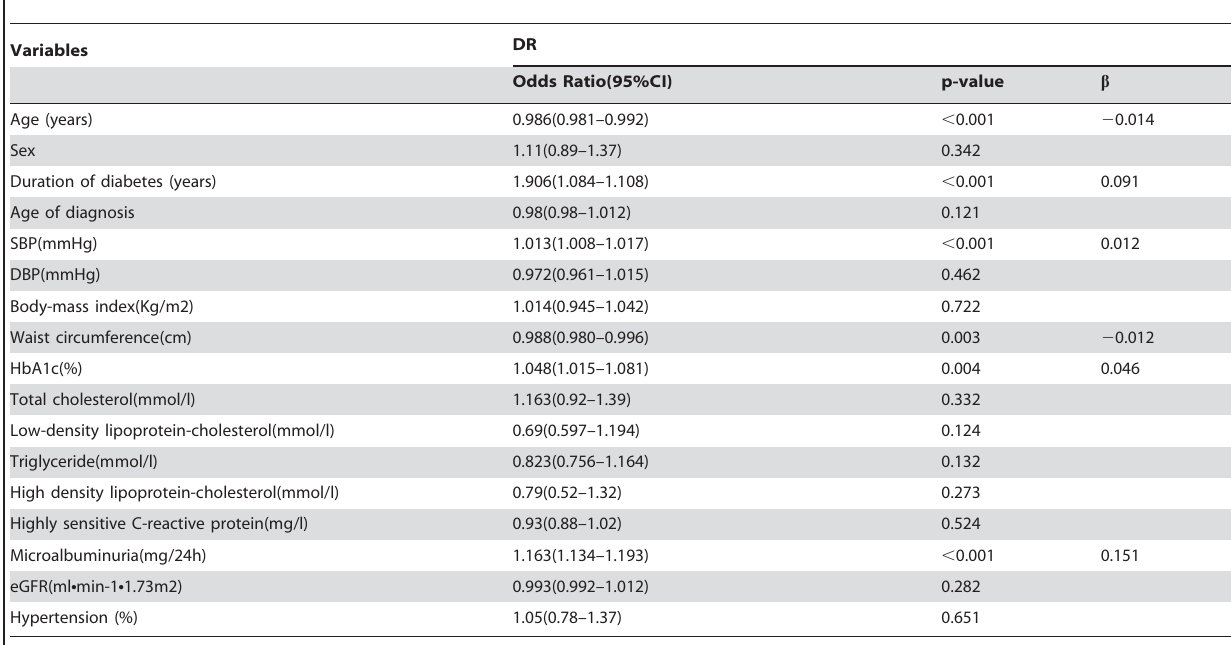
Table 2. Risk factors according to presence or absence of diabetic retinopathy as evaluated by a logistic regression model in 4,739 diabetes patients.